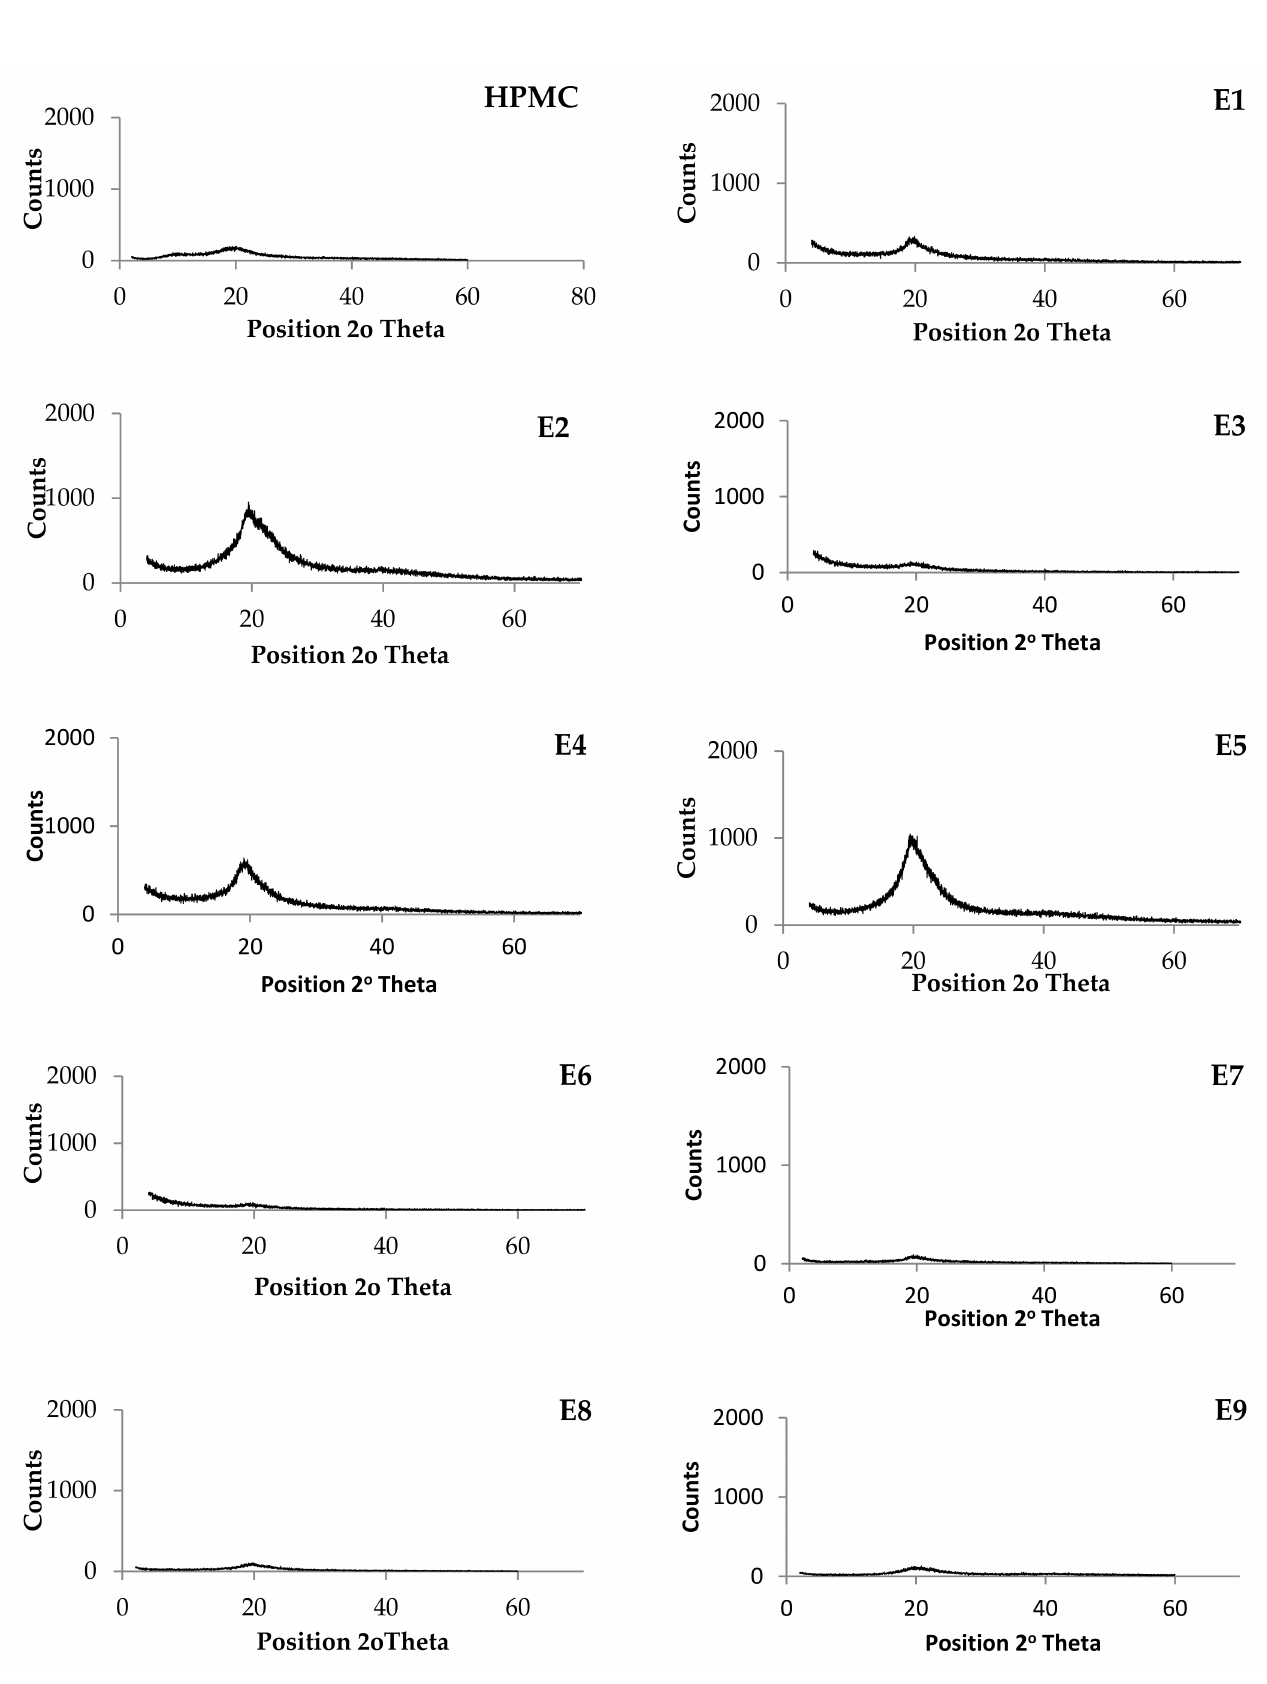
Figure 3. Powder X-ray diffraction of NFs formulae (E1–E9) in comparison to that of the pure (RLX, PVA, CS,